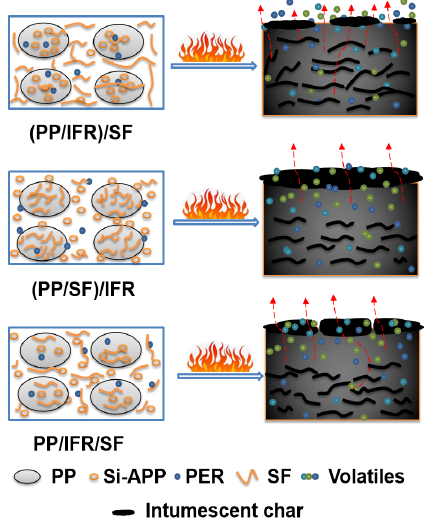
Figure 7. Possible flame-retardant mechanism of PP/SF flame-retardant